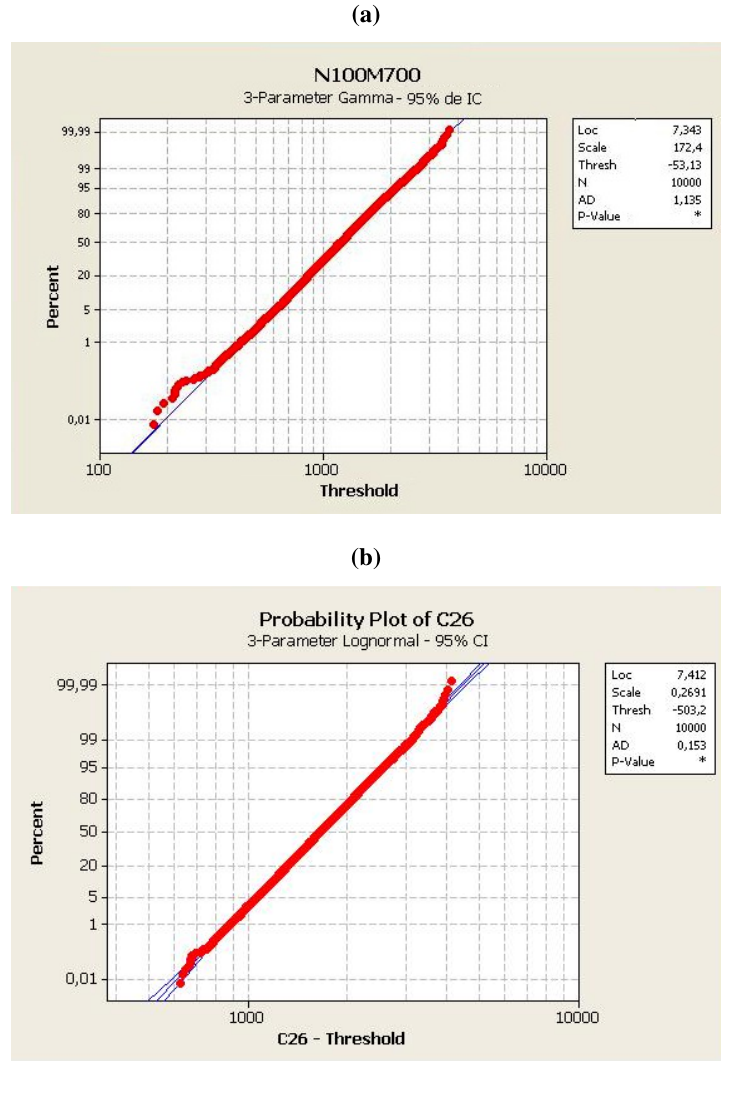
Figure 6. Anderson–Darling tests of compliance with distributions. ( a ) Compliance with the gamma distribution with 3 parameters; ( b ) Test of compliance with the log-normal distribution with 3